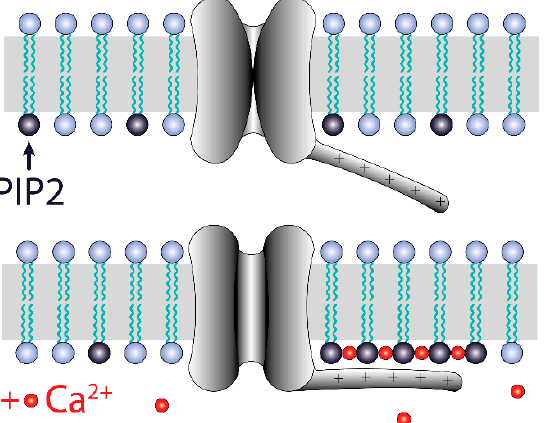
Figure 12. Model of TREK ‐ 2 ‐ like channel activation by the PI(4,5)P2/Ca2+ nanocluster. Ca2+ facili ‐ tates the aggregation of PI(4,5)P2 molecules in the inner leaflet of the plasma membrane. Calcium ions are attracted to the plasma membrane during depolarization, so the formation of PI(4,5)P2 nanoclusters is more likely at positive potentials than at negative potentials. The nanoclusters elec ‐ trostatically tether the C ‐ terminus domain bearing positively charged amino acids. This interaction stabilizes the open ‐ channel conformation. The voltage ‐ dependent formation of nanoclusters results in voltage dependency of the TREK ‐ 2 channel activity.